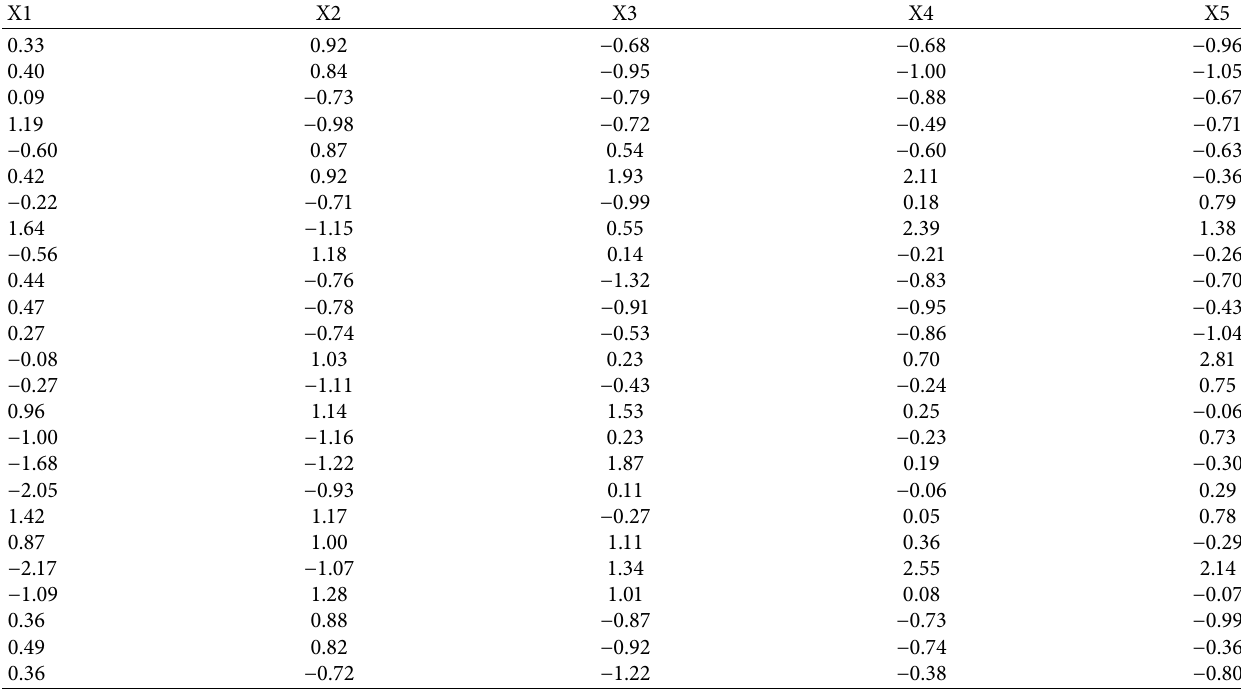
Table 1: Standardized data of the catenary detection parameters in this section.